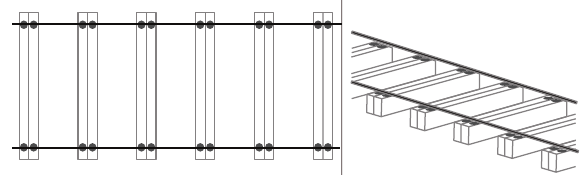
Figure 4: Railway track with stiff type of sleepers with double-point fastening